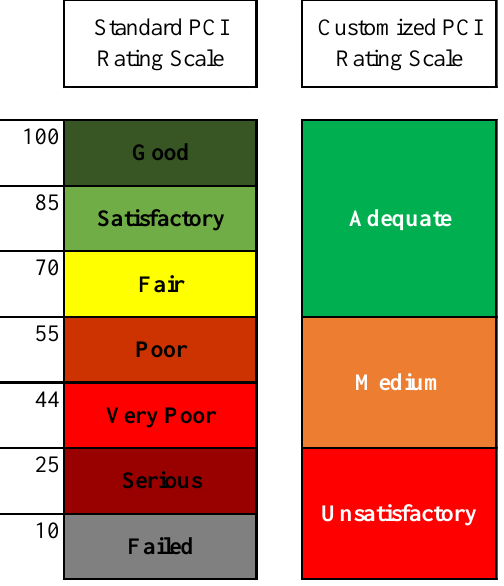
Figure 2. Standard and customized PCI rating scale.